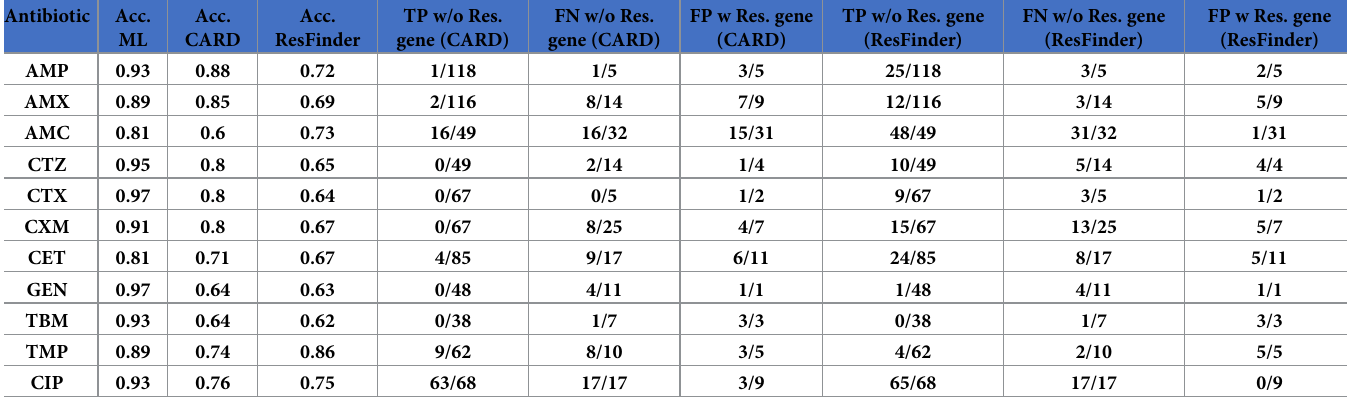
Table 2. Comparison of prediction results with a rule-based models with Resfinder and CARD database of antibiotic resistance genes. Antibiotic Acc.